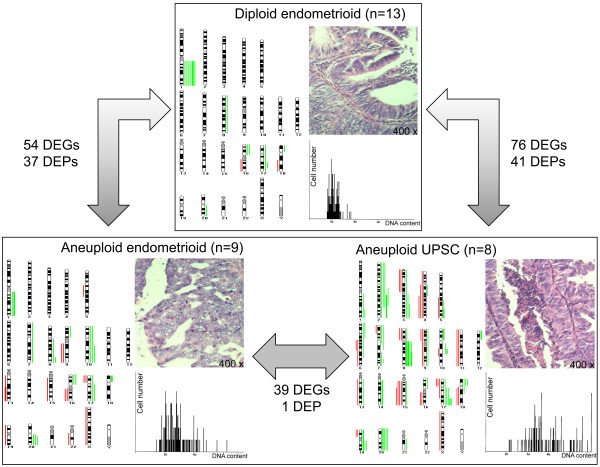
Examples of ploidy types and number of differential expressed genes (DEGs) and proteins (DEPs). DNA histograms show DNA content on the x-axis and the total number of cell on the y-axis.